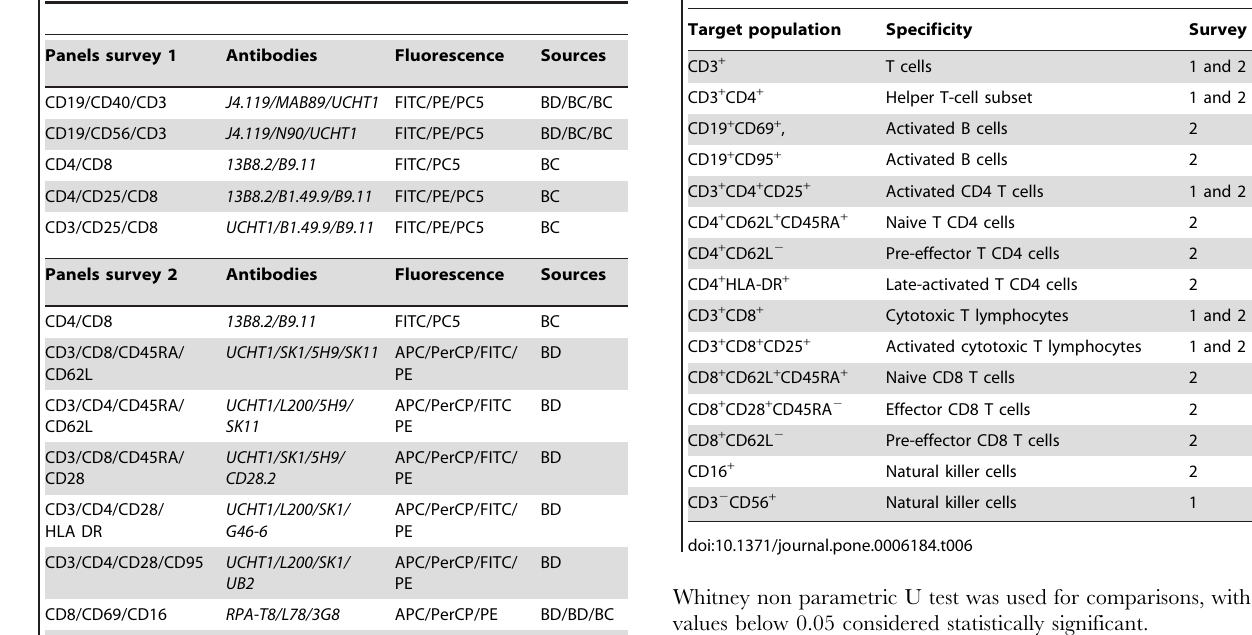
Table 5. Monoclonal antibodies (mAbs) used in surveys 1 and 2. Source: BC, Beckman Coulter (Fullerton, CA, USA); BD Becton Dickinson (Franklin Lakes, NJ, USA).